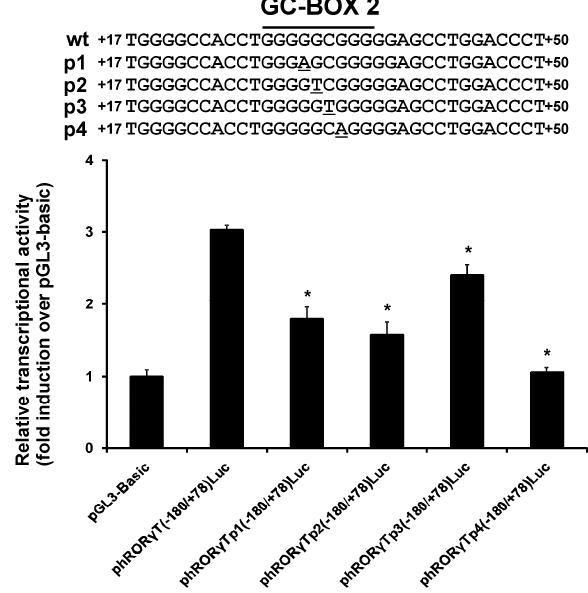
Figure 2. Effect of introduced polymorphisms of GC-box2 on the activity of the ROR γ T proximal promoter in Jurkat cells; phROR γ T( − 180/+78)Luc contains the wild-type sequence (wt), whereas